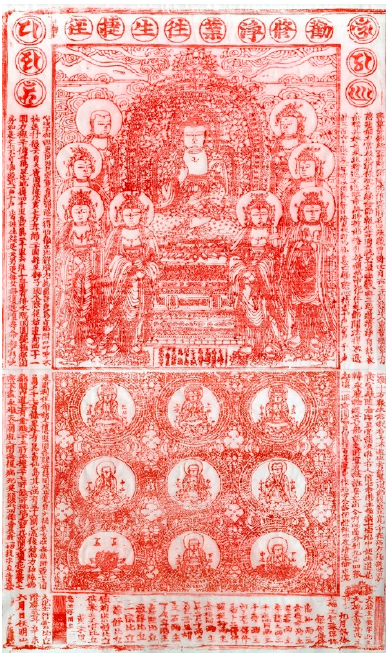
Figure 9. Shortcut to Rebirth through Buddha Mindfulness (K. Gwonsu jeongeop wangsaeng cheopgyeongdo ), Woodblock carved at Ssanggyesa Temple, Eunjin, Joseon (1571), 39.0 × 56.4 cm, Dongguk University Museum. Photo by the author.